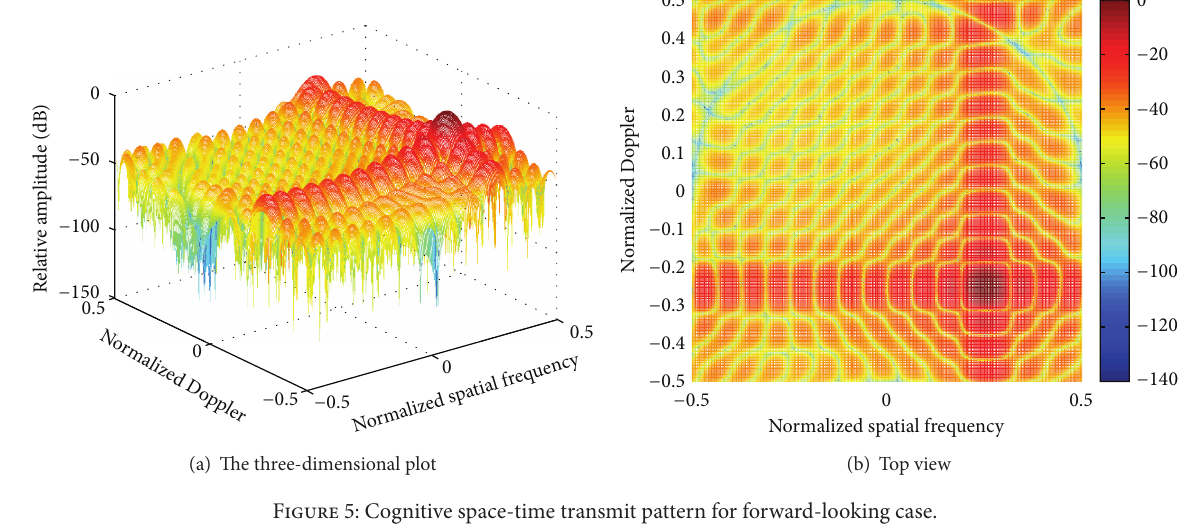
Figure 5: Cognitive space-time transmit pattern for forward-looking case.